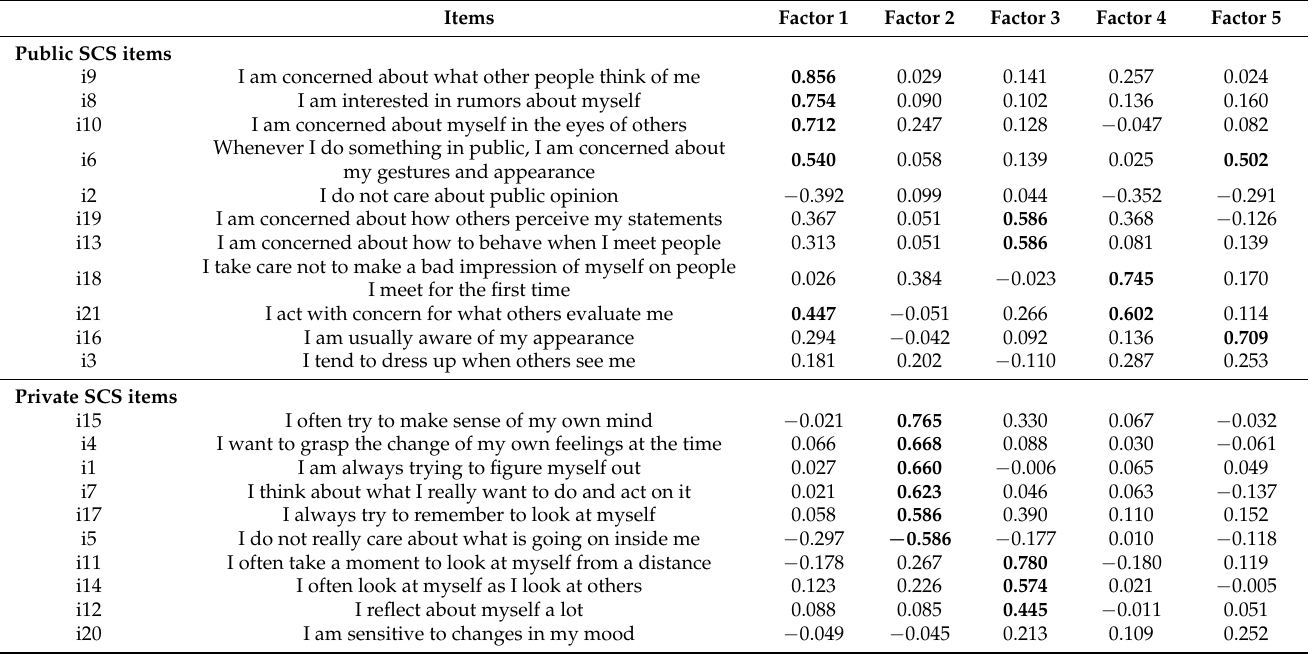
3.2. Results from Factor Analysis The exploratory factor analysis revealed five representative orthogonal factors. Each factor explained 14.1%, 14.1%, 11.1%, 6.9%, and 5.5% of the total variance, respectively. The matrix structure with the factor loadings and items is presented in Table 2. Table 2. Questionnaire items of the Self-Consciousness Scale (SCS), identified factors, and their loadings.